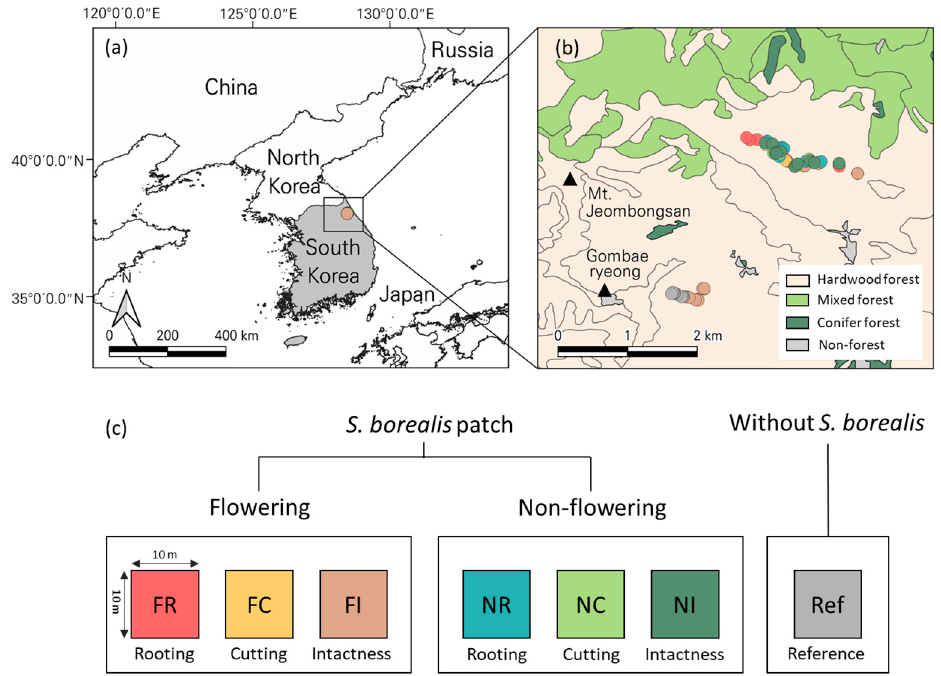
Figure 2. Study area and stand layouts. ( a ) Location of Mt. Jeombongsan in Seoraksan National Park in the Korean peninsula, ( b ) map of the study sites (circle) at Mt. Jeombongsan. Refer to ( c ) for the color code of the study sites and ( c ) layout of seven understory types according to Sasa flowering, wild boar rooting activity, and culm cutting. FR: flowering and rooting, FC: flowering and cutting, FI: flowering and intactness, NR: non-flowering and rooting, NC: non-flowering and cutting, NI: non-flowering and intactness, Ref: reference.